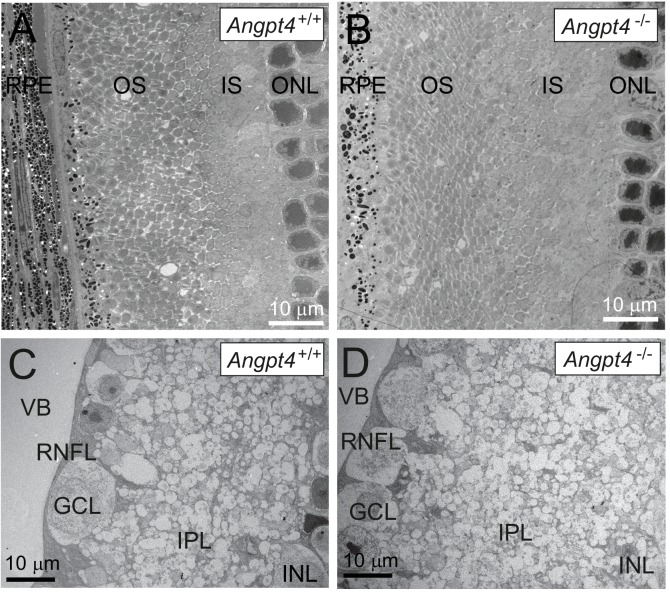
Ultrastructural analysis of retinal layers in adult mice.TEM reveals no alterations in the outer (A-B) or superficial (C-D) retinal layers in Angpt4-/- mice. RPE, retinal pigment epithelium; OS, photoreceptor outer segment; IS, photoreceptor inner segment; ONL, outer nuclear layer; INL, inner nuclear layer; IPL, inner plexiform layer; GCL, ganglion cell layer; RNFL, retinal nerve fiber layer; VB, vitreous body.